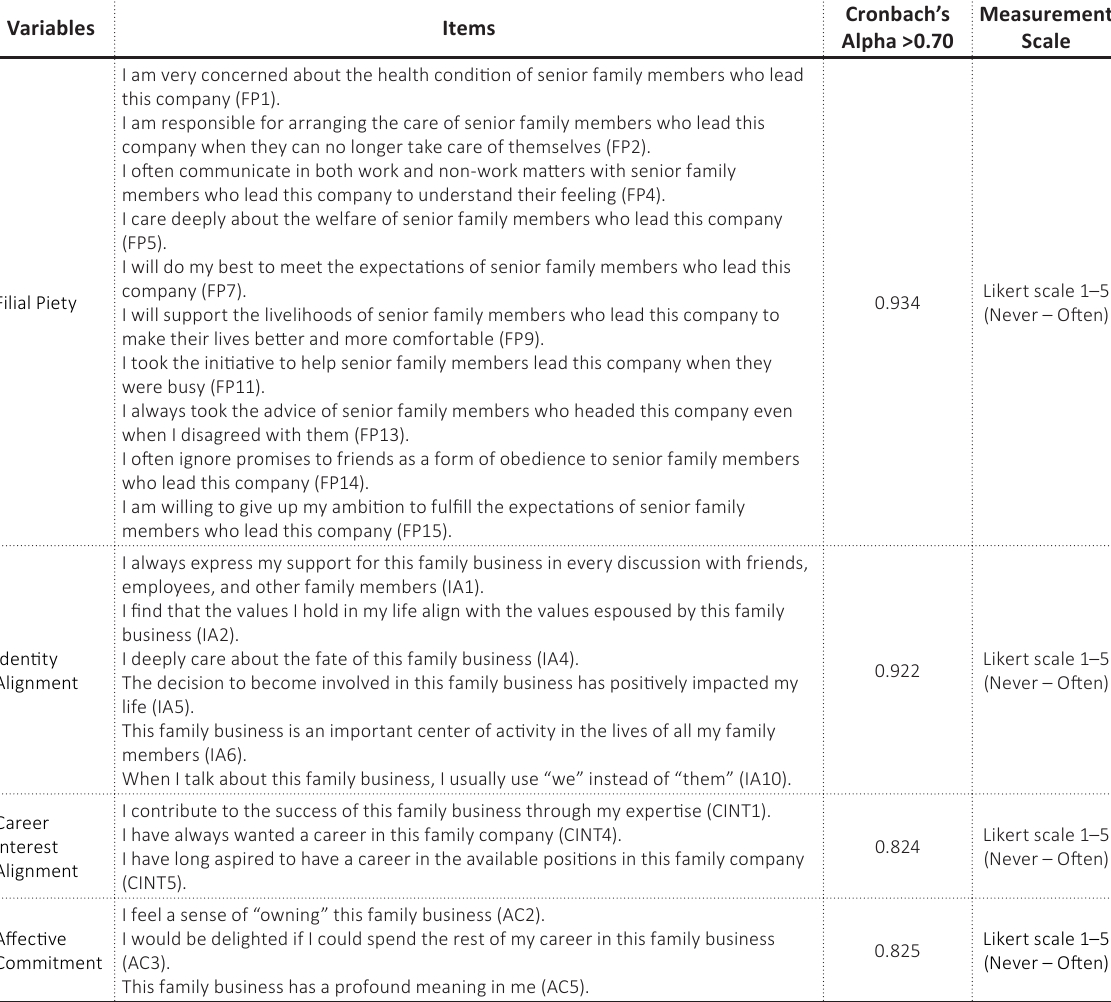
Source: Primary data